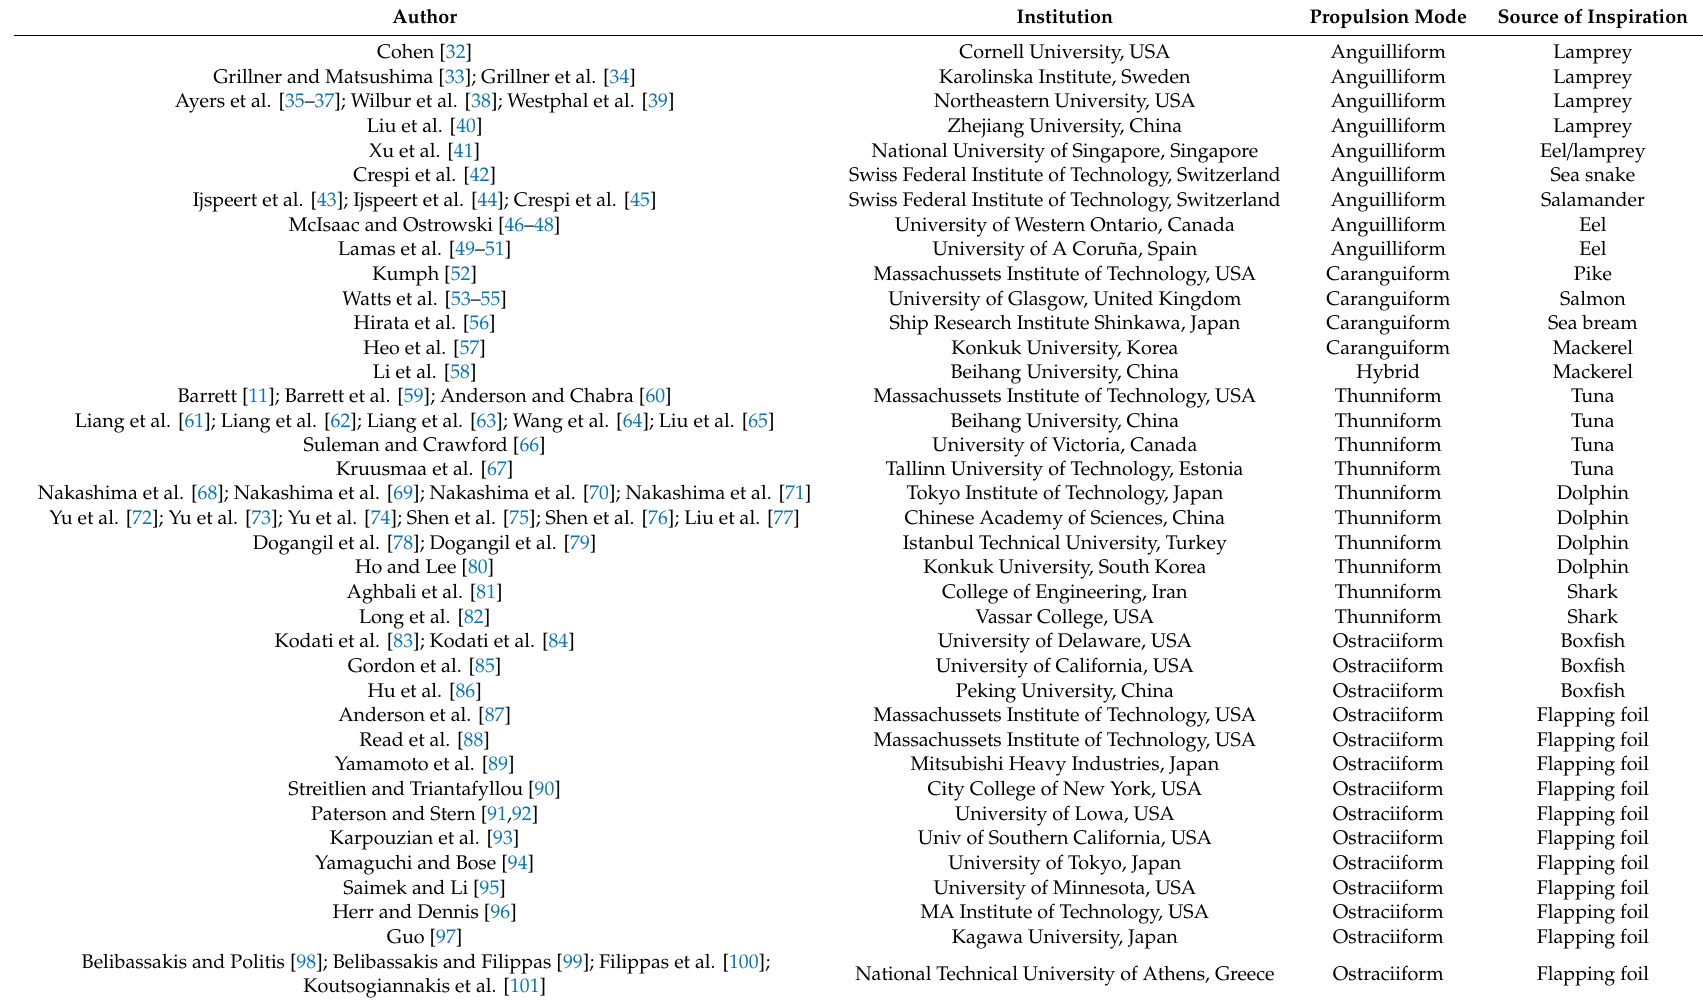
Table 1. Summary of body and / or caudal fin (BCF) swimming